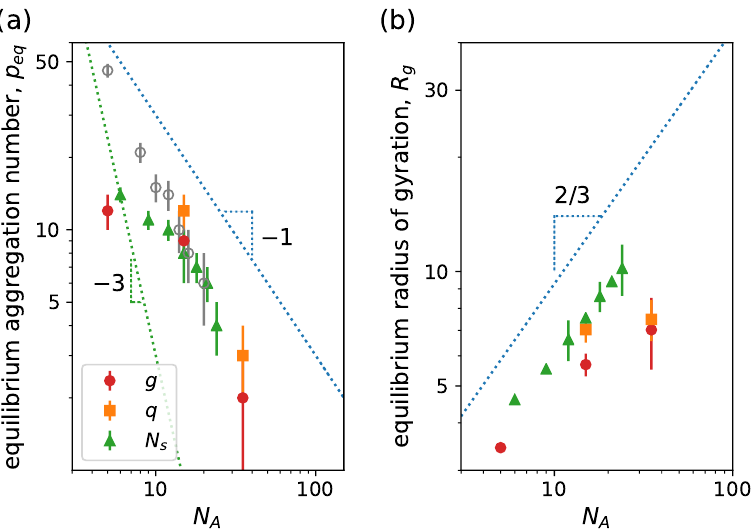
Figure 11. ( a ) Equilibrium aggregation number and ( b ) equilibrium radius of gyration versus degree of polymerization of the hydrophilic block N A . We consider linear–dendritic charged block copolymers. Different type of dots correspond to simulation results with variation in N A by changing the indicated parameter, see Equation (5): red circle indicates variation of g = 0,1, with q = 2, N s = 5 and N B = 5; orange square for variation of q = 1,2 with g = 2, N s = 5 and N B = 5; and green triangle for variation of N s = 3,4,5,6,7 with g = 2, N s = 2 and N B = 10. In ( a ), gray circles correspond to simulation results from Figure 7 for linear charged block copolymers. Dotted lines correspond to scaling predictions from SCF theory for linear block copolymers with ionic hydrophilic blocks [42]: Blue lines correspond to the limit of small aggregation number, where p (cid:28) α − 1/2 λ − 1 the green line corresponds to the limit of large aggregation number, where p (cid:29) α − 1/2 λ − 1 system parameters: w c = 2.5, (cid:101) attr = 1.0 and k B T =